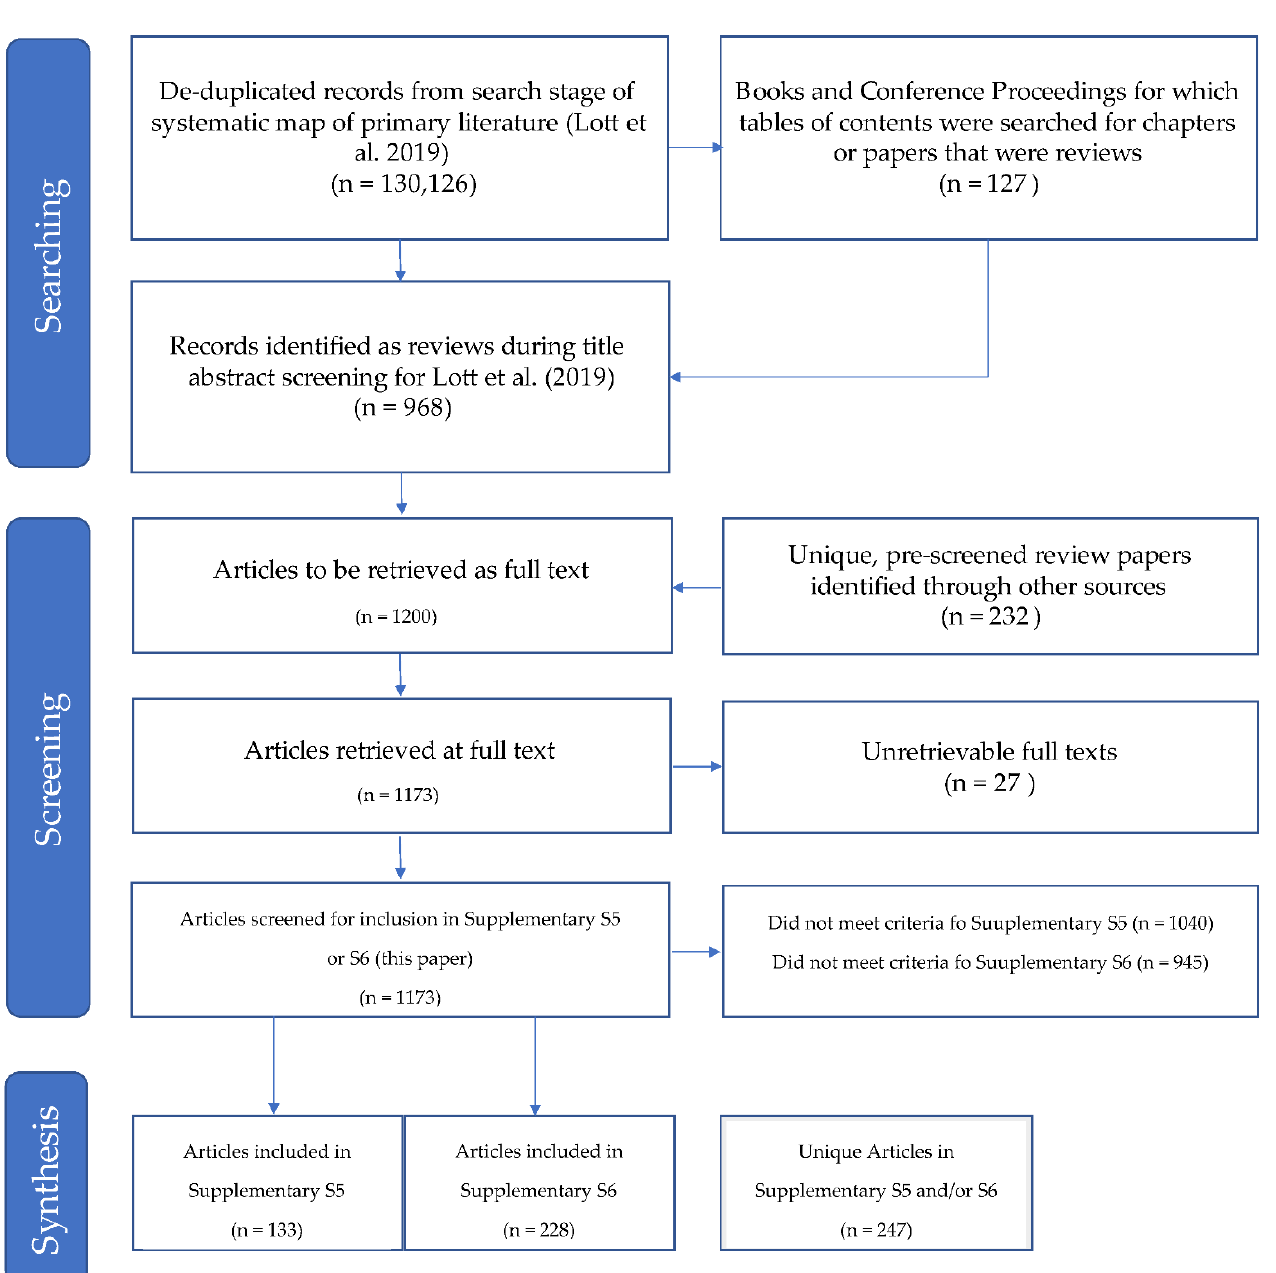
Figure 1. RoSES reporting form for systematic maps (Haddaway et al. 2017) [94] illustrating the number of references found during literature searches; the number of references subjected to title only, title–abstract, and full-text screening; and the number of references that met inclusion criteria for Supplementary S5 and S6.